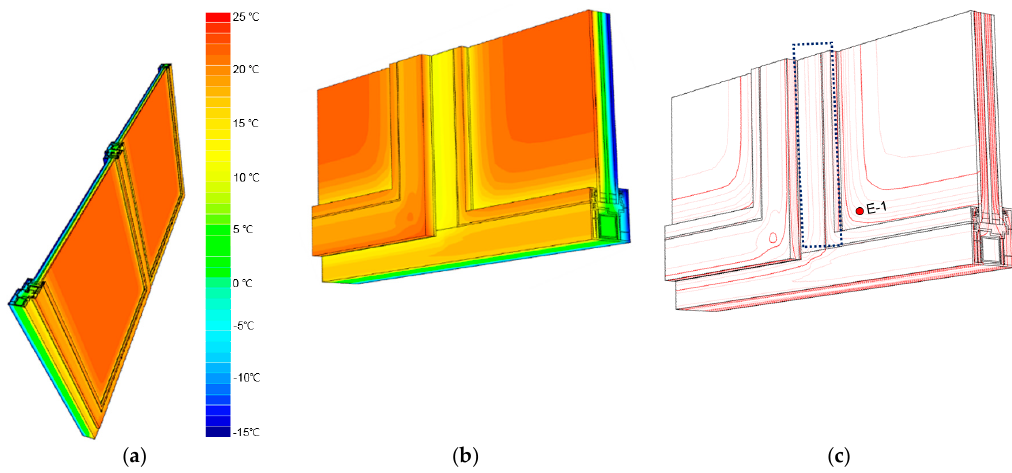
Figure 10. 3D isotherms: ( a ) isotherms for a whole window; ( b ) part of a window; and ( c ) isothermal lines and Point E-1.